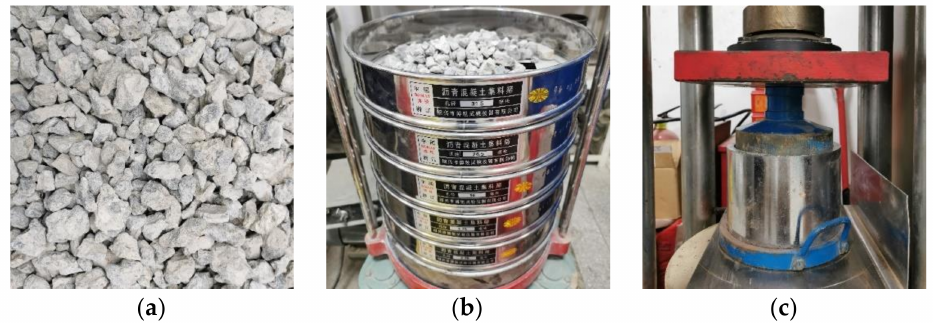
Figure 1. The recycled aggregate. ( a ) The processed recycled aggregate; ( b ) the size distribution test; ( c ) the crushing test.